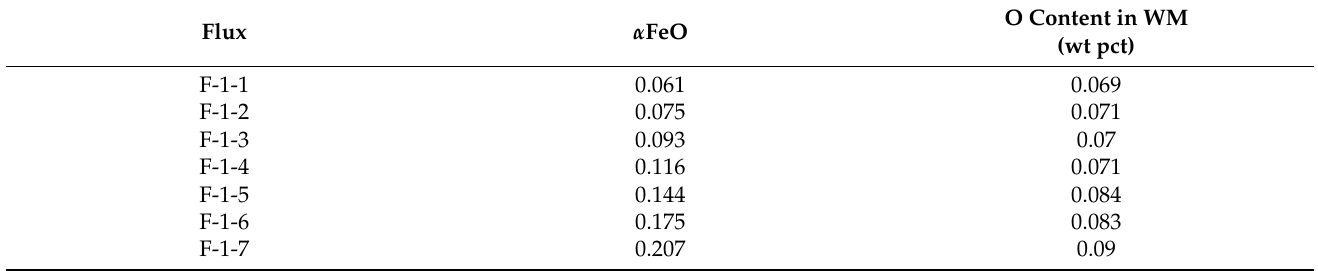
Table 5. FeO activity at